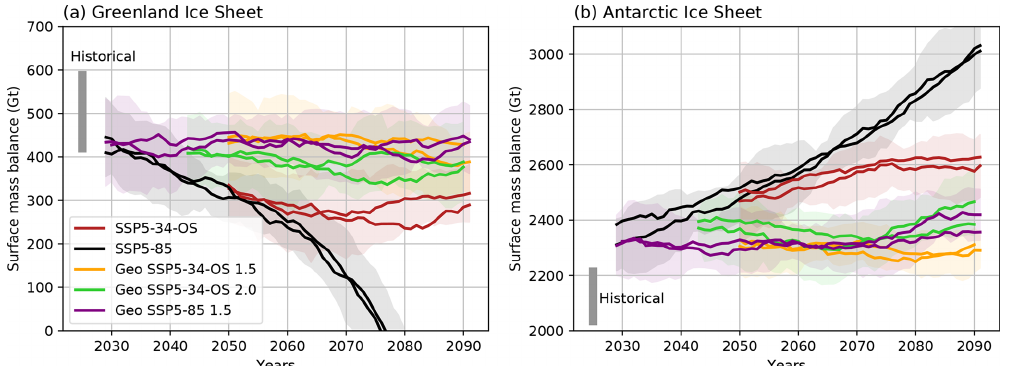
Figure 10. Mean ice sheet surface mass balance (SMB) in Gtyr − 1 . Shading indicates standard deviation of one of the members, calculated after detrending the time series using empirical model decomposition. A 20-year running mean has been applied to filter out year-to-year variability. For the Greenland Ice Sheet (GrIS) (a) , the area of integration is the contiguous ice sheet (1699077km 2 ). For the Antarctic Ice Sheet (AIS) (b) , the area of integration is the grounded ice sheet (12028595km 2 ). The solid grey bar indicates the ± 1SD (standard deviation) SMB over the period 1960–1999 in CESM2 (WACCM) for